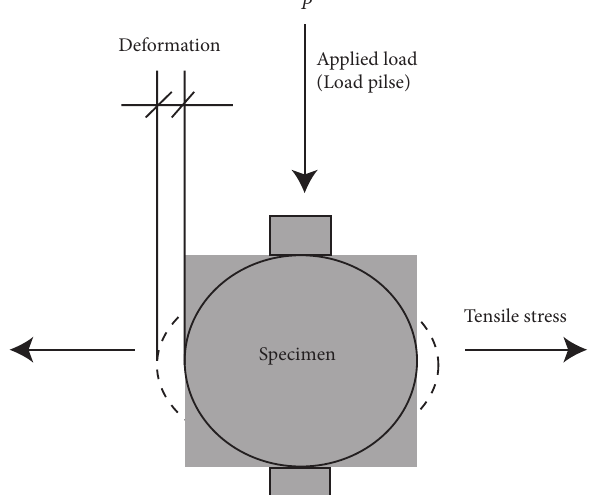
Fig. 2 . Type of the cylindrical specimen (core) load (Sivapatham, Beckedahl 2005) Table 1. Comparison of properties of the bitumen binders B70/100 and ModBit 80B